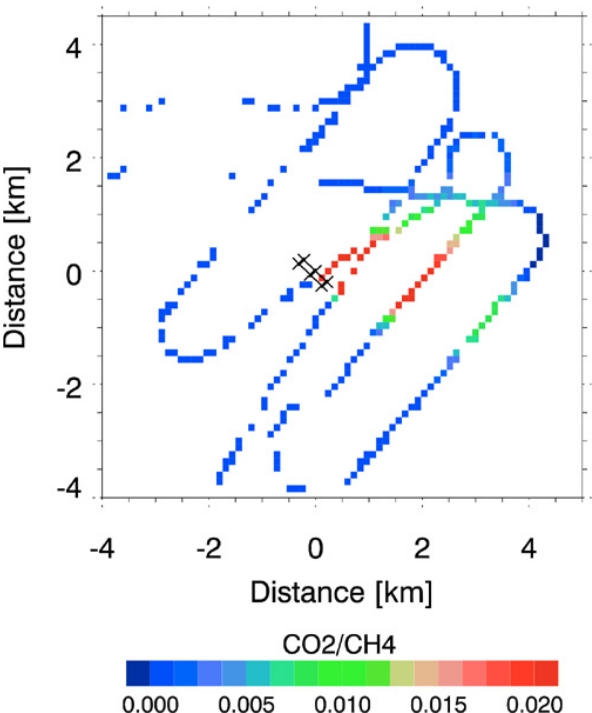
Fig. 11. Propagated error on the retrieval result due to error on the conversion factor, because of insufficient knowledge of the plume height and vertical distribution. Highest deviation from the true value is about 0.06% relative to the background column. The er- ror in the conversion factor estimation leads to a bias of + 1.33% of the true emission rate using the plume inversion